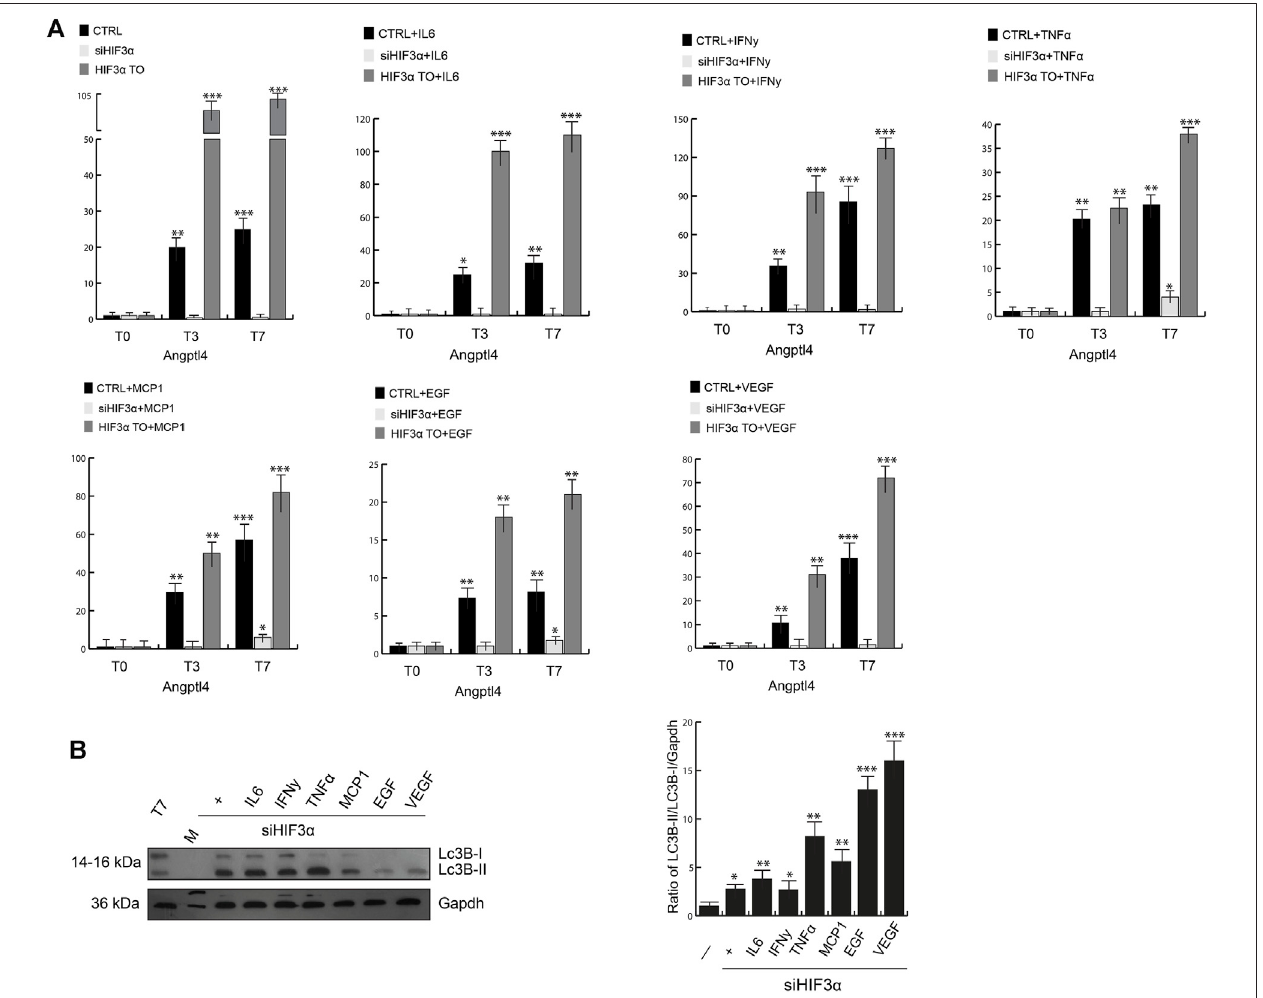
FIGURE3| Hif3 α silencingenhanceslipid catabolism. (A) Expressionlevelsof Angptl4 byqPCR inWT,si Hif3 α , HIF3A TOcultured indifferentiatedmedium (T0-T7) in presence or absence of cytokines. Relative gene expression data are reported as 2- ΔΔ Ct method, normalized to housekeeping gene (b-actin and 18S mRNA) vs. T0 WT. Data are expressed as means ± SEM ( n (cid:2) 3; *** p ≤ 0.001, ** p ≤ 0.01, * p ≤ 0.05). (B) Western blot analysis of LC3B-II protein in siHif3 α adipocytes cultured in differentiationmediuminpresenceofin fl ammatorycytokines(T7).TheratioofLc3B-II/Lc3B-I/GapdhwasmeasuredusingImageJAnalysistool( n (cid:2) 3;*** p ≤ 0.001, ** p ≤ 0.01, * p ≤ 0.05 vs . control